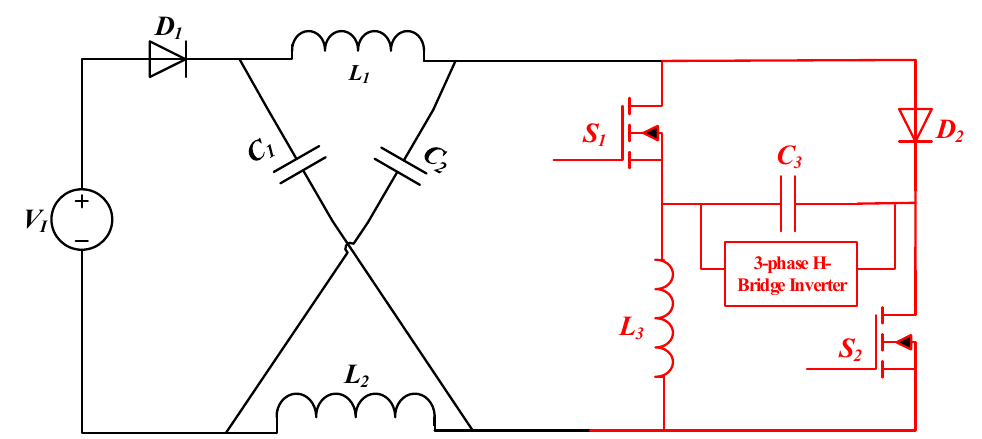
Figure 3. The proposed high step-up switched Z-source converter (HS-SZSC). During the switch-on period, capacitors will supply energy to inductors; hence, the inductor current will increase and store the energy, while the capacitor voltage will be rising during the switch-off period, as inductors will release the energy to capacitors and proposed